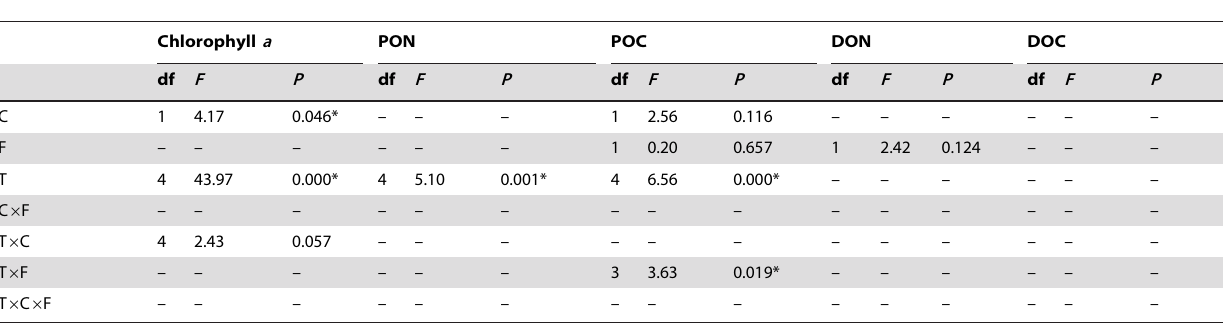
Table 1. Results of the 3-factorial ANOVA of the water parameters.